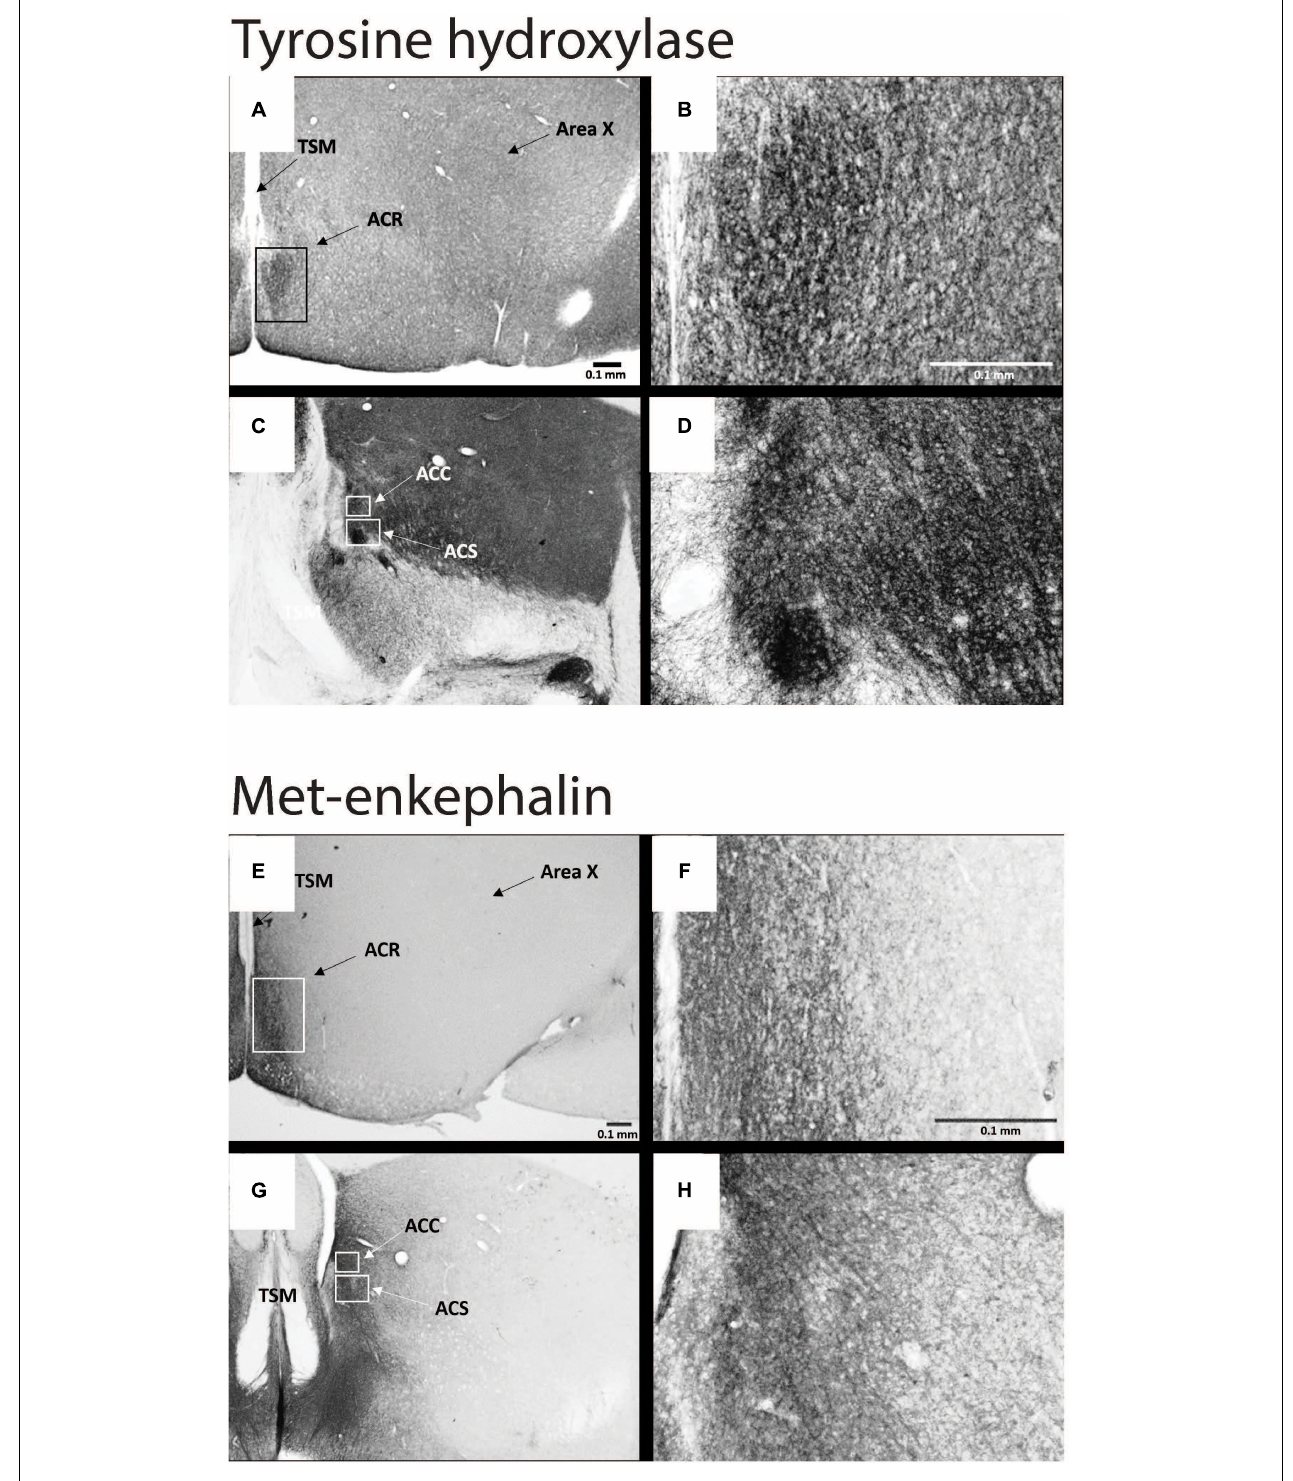
FIGURE 4 | Subdivisions of NAc contain dopamine- and opioid-related immunolabeling in male starlings. Photomicrographs of immunolabeling for tyrosine hydroxylase at low (A,C) and high (B,D) magnification and of met-enkephalin at low (E,G) and high (F,H) magnification. See Figure 3 for abbreviations. Figures modified with permission from Polzin et al.